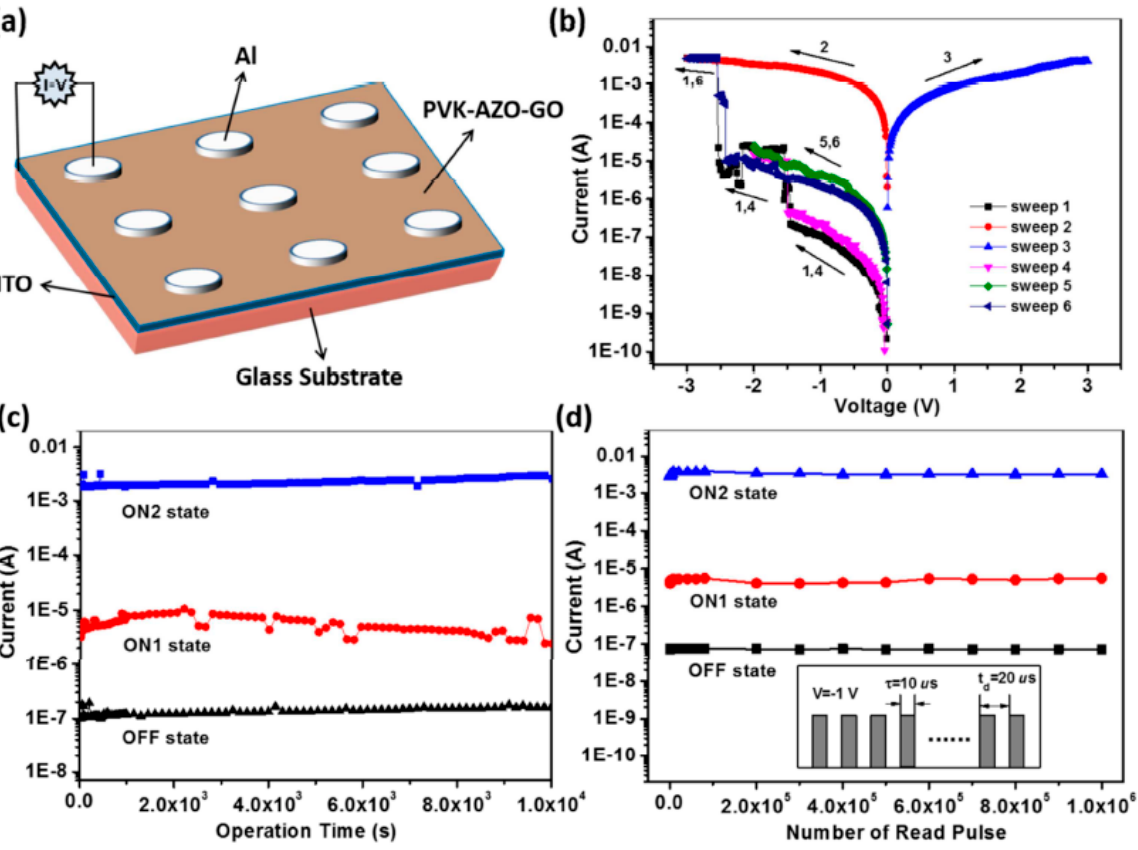
Figure 13. ( a ) Al/PVK-AZO-GO/ITO device: ( b ) I-V properties, ( c ) Impact of operating duration on OFF, ON1, and ON2 state currents subjected to − 1 V, and ( d ) Impact of reading pulses of − 1 V on OFF, ON1, and ON2 state currents. The inset of ( d ) displays the measurement pulse [120].